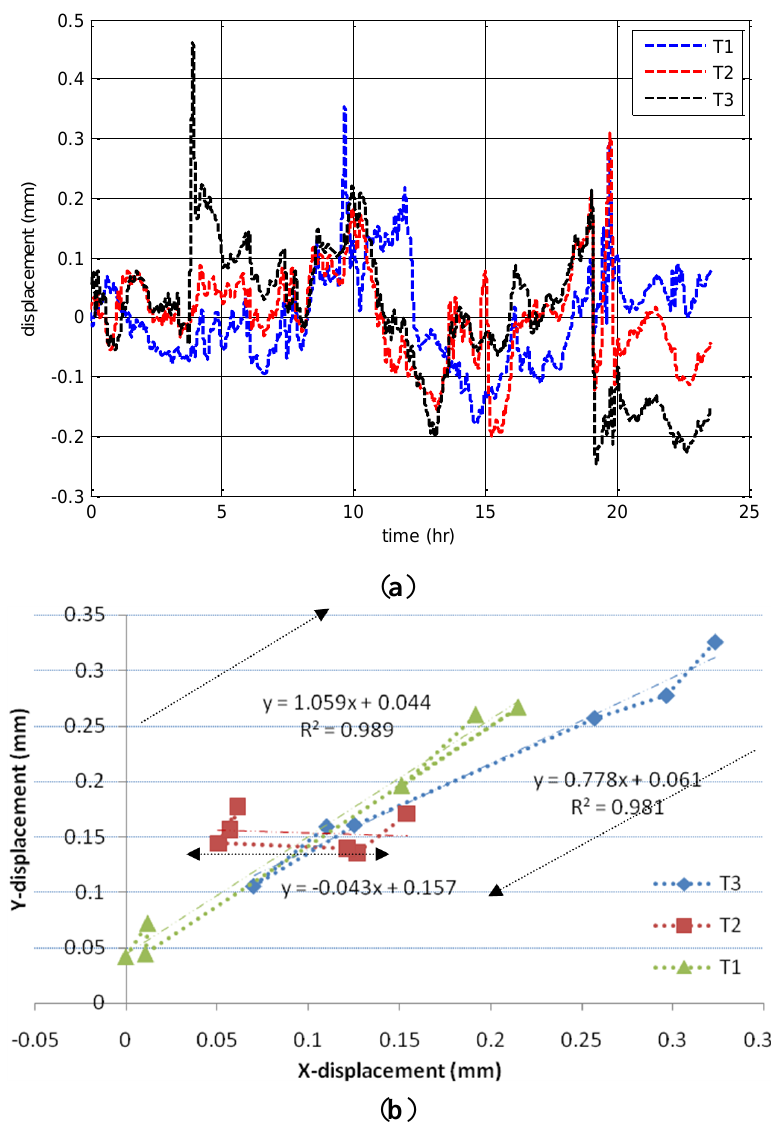
Figure 11. ( a ) The time series of Displacement in Y-direction and ( b ) scattered of GPS measurements for the three towers of bridge(the arrows refers to the movement